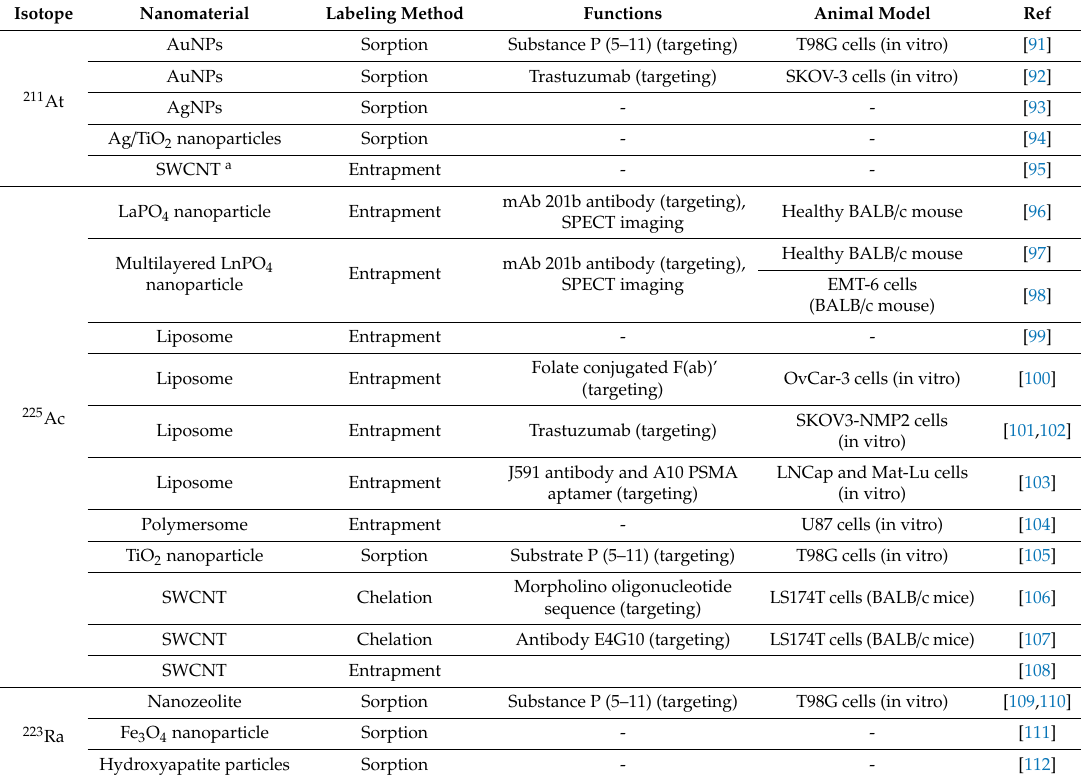
Table 5. Representative studies on α -particle therapy using functional